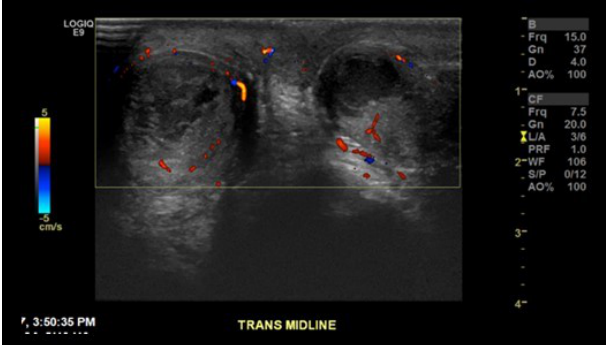
Figure 5. Scrotal ultrasound with color Doppler done approx- imately one month post-operatively demonstrates normal flow to both